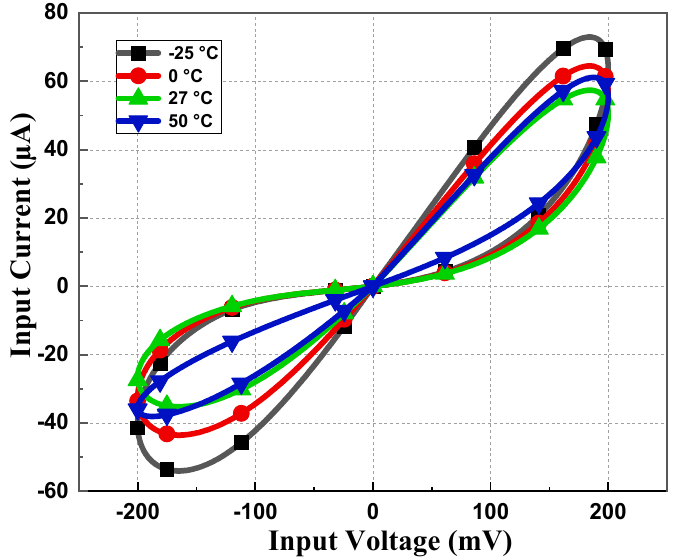
Figure 11. PHL at different temperatures at 5 MHz with 10 pF capacitor value.